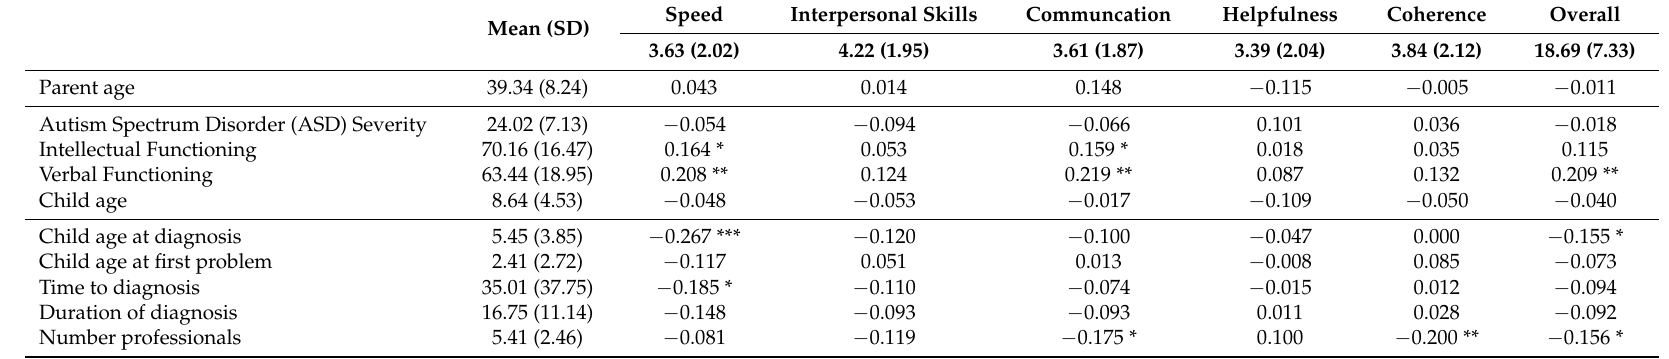
Table 2. Spearman correlations between parent, child, and diagnostic process factors and the parents’ perceived view of the diagnostic